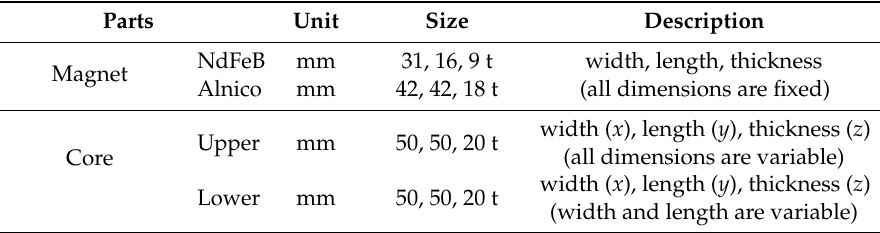
Table 2. Constraints used in the 3D FEM model.